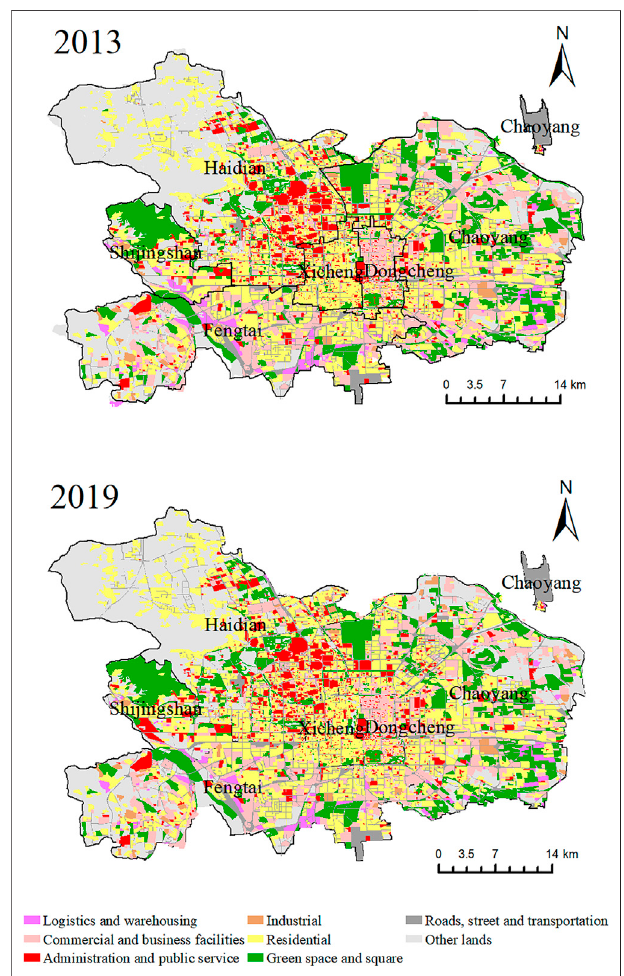
FIGURE 6 | Interpretation vector diagram of eight types of land in six districts of Beijing in 2013 and